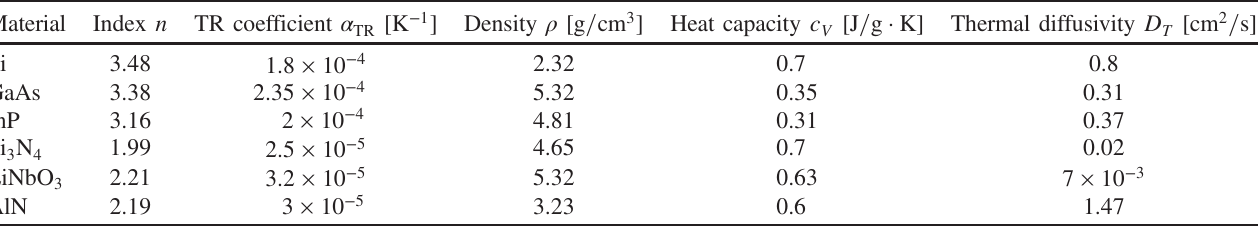
TABLE II. Material properties used to calculate the thermal noise limits in Fig. 4 of the main text. Aluminum nitride is the only material listed with a favorable thermo-optic coefficient and thermal